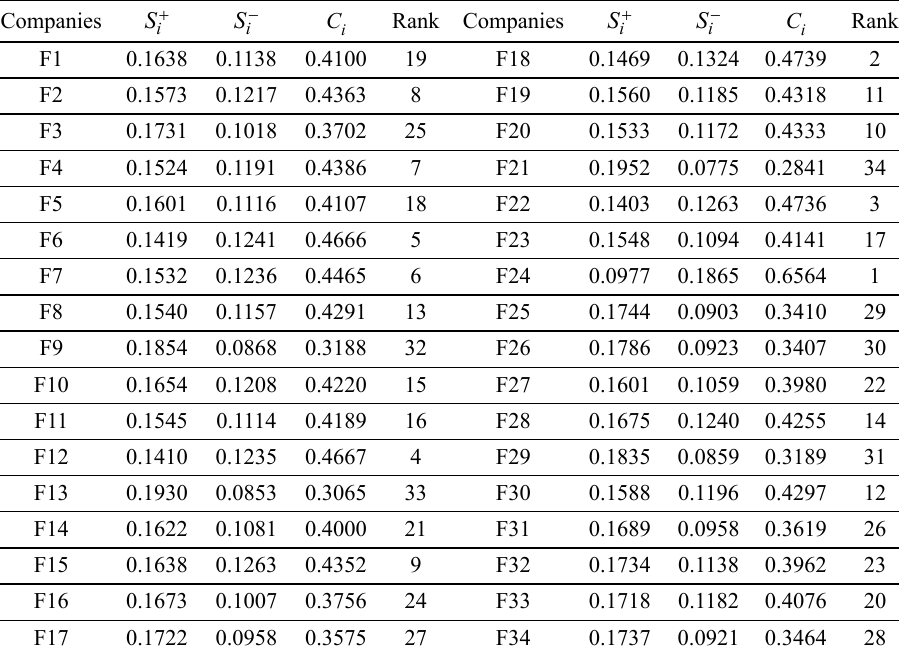
Table 2. The distance measure, relative closeness coefficient and ranking Companies